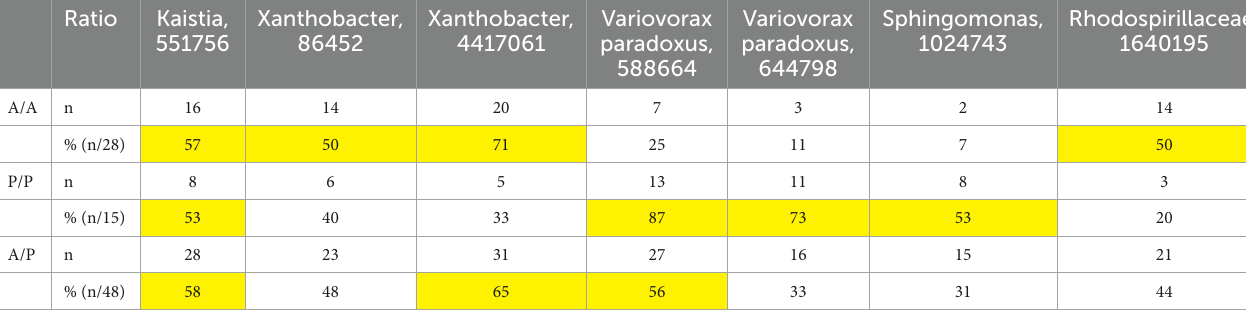
TABLE 1 Comparative analysis of the abundance of bacterial taxa.